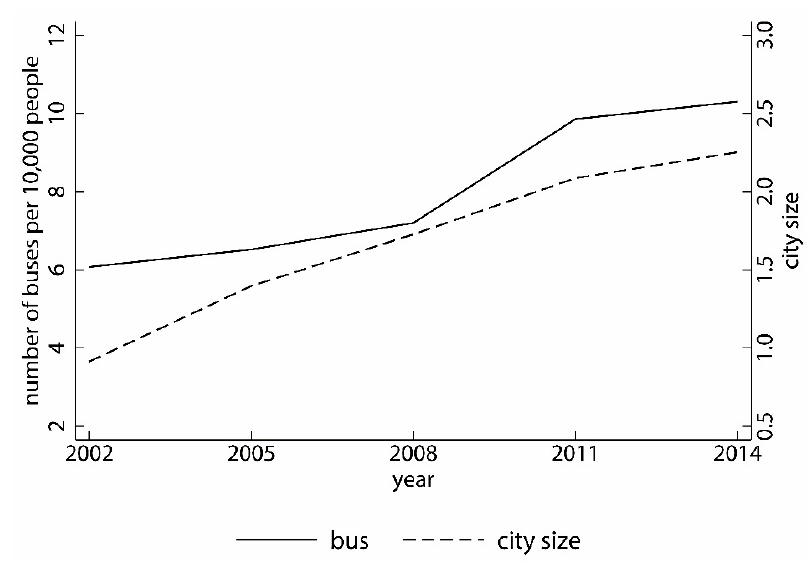
Figure 3. Trends in city size and the number of buses per 10,000